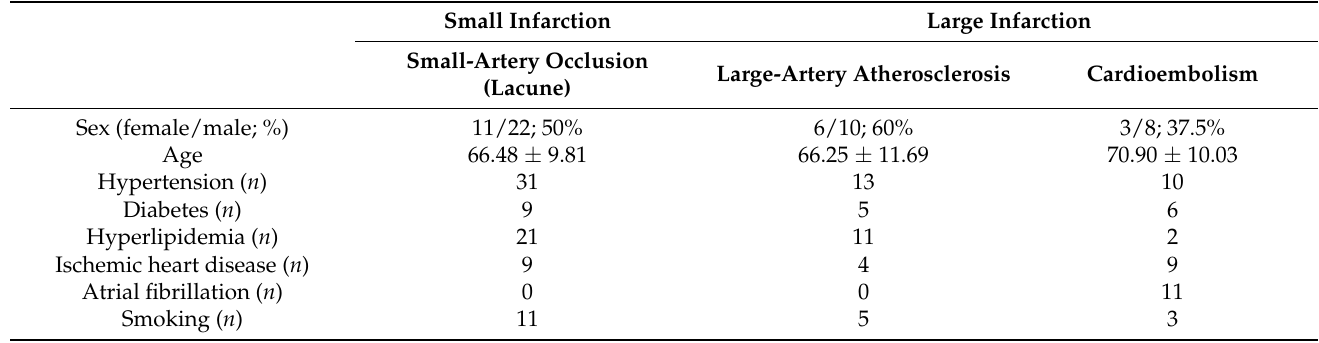
Table 1. Demographic data of 60 patients with stroke.